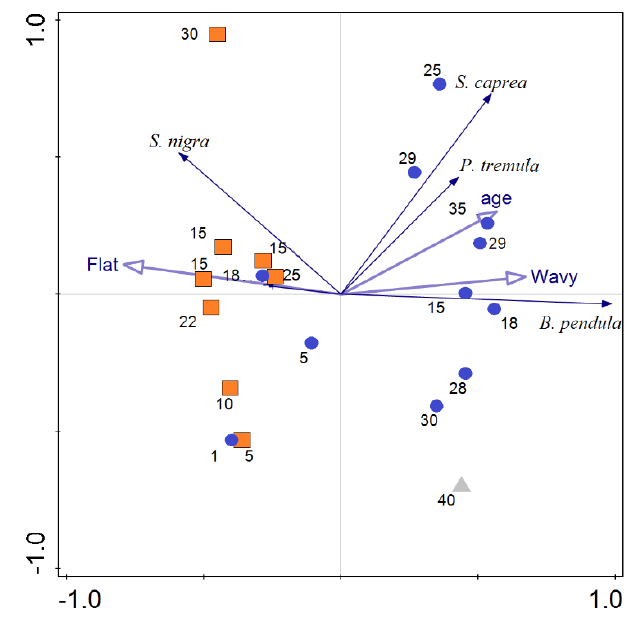
Figure 3. Principal-component analysis (PCA) of dominant tree and shrub composition in postmining sites of various ages that were either levelled (orange squares) or not (blue circles), and a forest unaffected by mining (grey triangle).